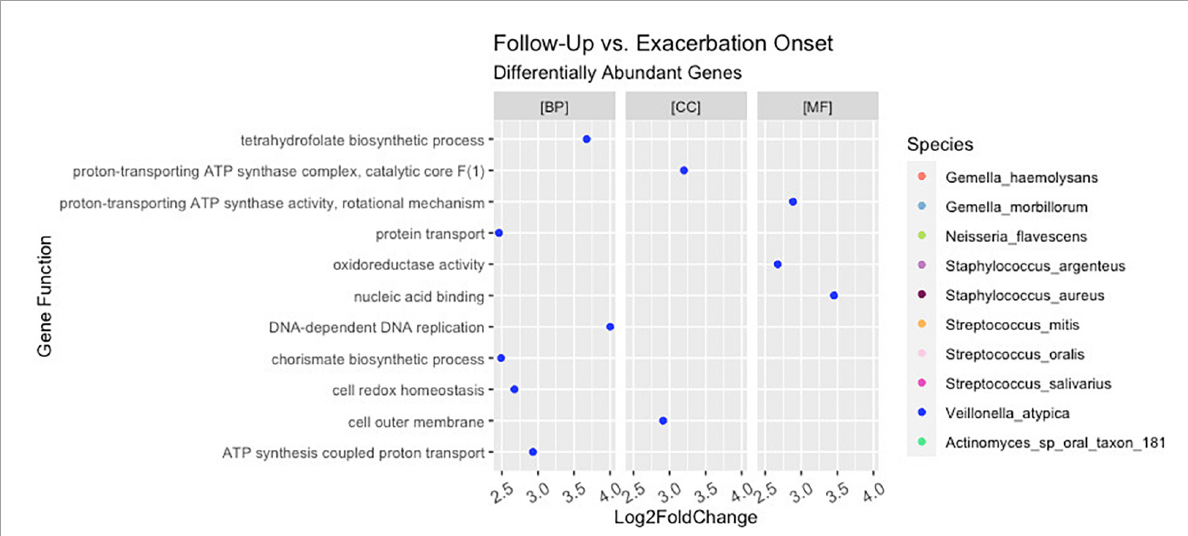
FIGURE5 Differential abundance of Veillonella atypica genes in follow-up versus pulmonary exacerbation. While ten bacterial species were identified to have a differential abundance of bacterial genes across clinical states (i.e., pulmonary exacerbation, end of treatment, and follow-up), only Veillonella atypica had a differential abundance of bacterial genes when comparing follow-up pulmonary exacerbation onset. BP, biological processes; MF, molecular functions; CC, cellular